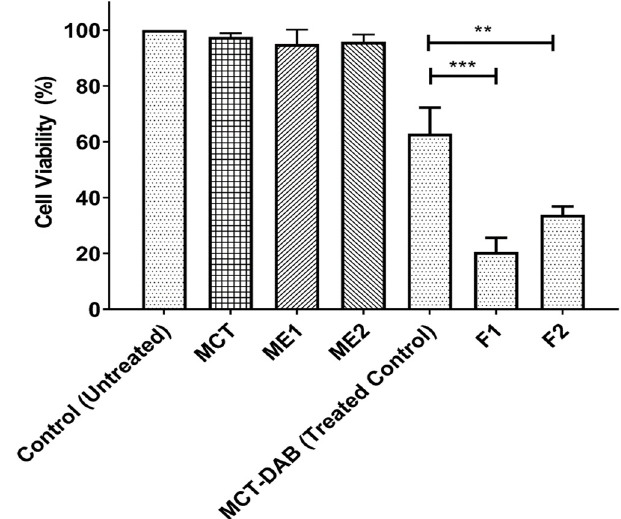
Figure 6. In vitro cytotoxicity of formulations with or without DAB in B16BL6 melanoma cell line at 50 µg/mL DAB concentration. All data are expressed as mean ± standard error, n = 3. *** p < 0.001 when F1 compared MCT-DAB. ** p < 0.01 when F2 compared to MCT-DAB.